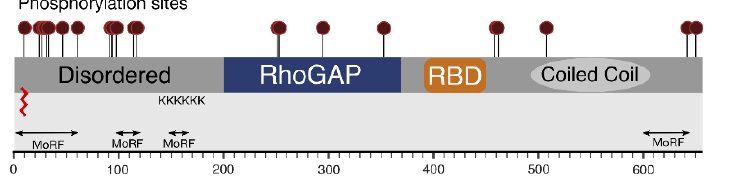
Figure 6. Compiled knowledge of the structure of RLIP76. Phosphorylation sites are shown as maroon lollipops. Predicted and known regions of structure are boxed. The predicted palmitoylation site is shown as a red zig-zag. The poly-lysine tract and predicted molecular recognition features are also shown.